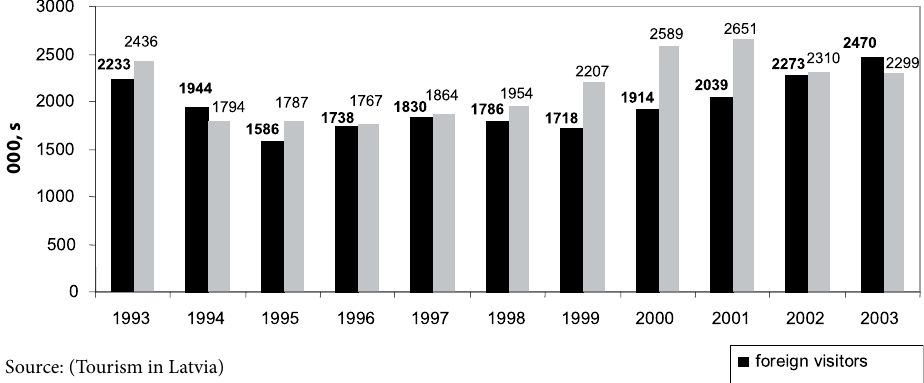
Fig. 1. Dynamics of incoming and outgoing travellers in Latvia 1993–2003